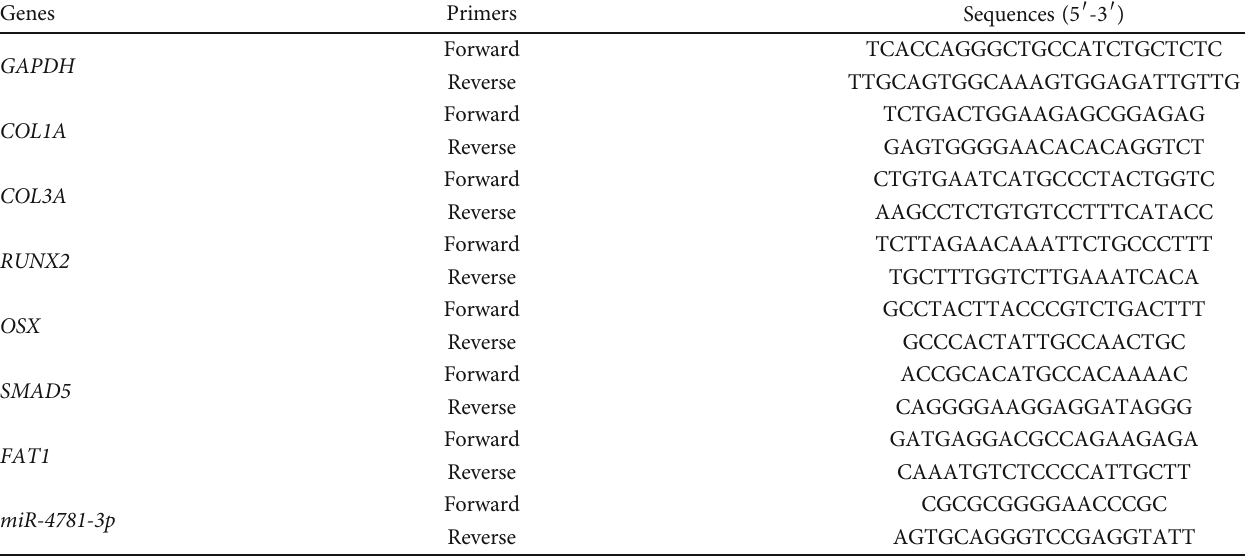
Table 1: Sense and antisense primers for